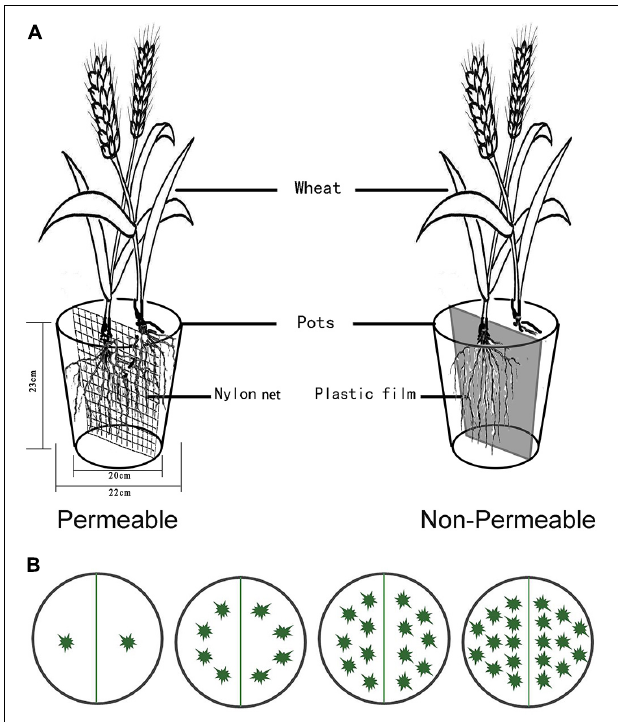
FIGURE 1 | Schematic diagram of the experimental units. (A) The partition between the two halves of the pot. Permeable (segregated by nylon net, “net”) and Non-Permeable (segregated by plastic film, “film”). (B) The planting density and layout.